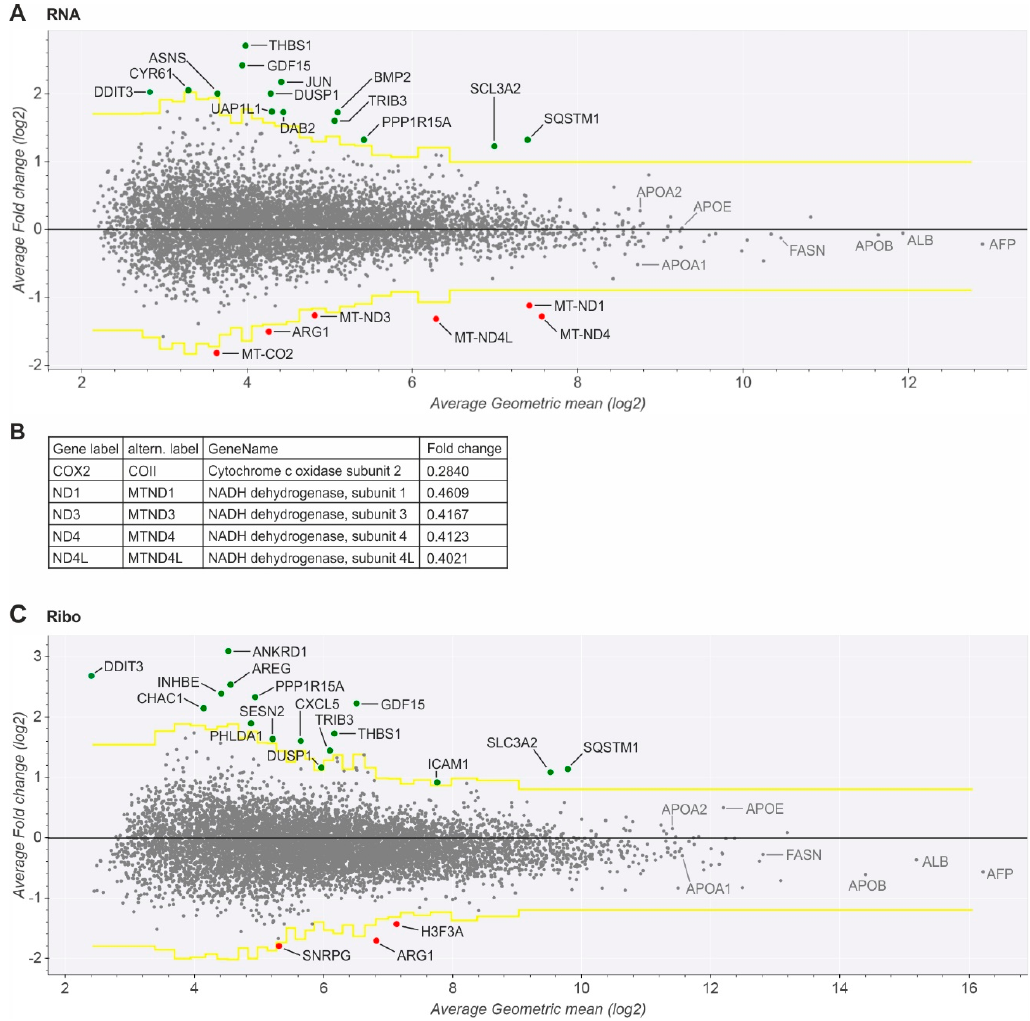
Figure 3. Gene expression in HCV-transfected versus mock-transfected cells 6 days after transfection, analyzed with the Differential plot in Trips-Viz [39]. ( A ) Transcriptome analysis (“RNA”). The x-axis denotes the log(2) of geometric mean read counts in complete mRNAs (minimum number of reads = 3, window size 25–40 bp) normalized by mapped reads, the y-axis the average log(2)-fold change (LFC) of expression. The black line indicates LFC = 0. The yellow lines indicate the significance threshold. Significantly upregulated genes are shown in green, downregulated genes in red. DDIT3 was under the read count threshold but is noted in the plot. ( B ) Downregulation values of mitochondrial genes in detail. ( C ) Ribosome profiling analysis (“Ribo”). Details are as in ( A ), but reads were counted in the coding sequence only.